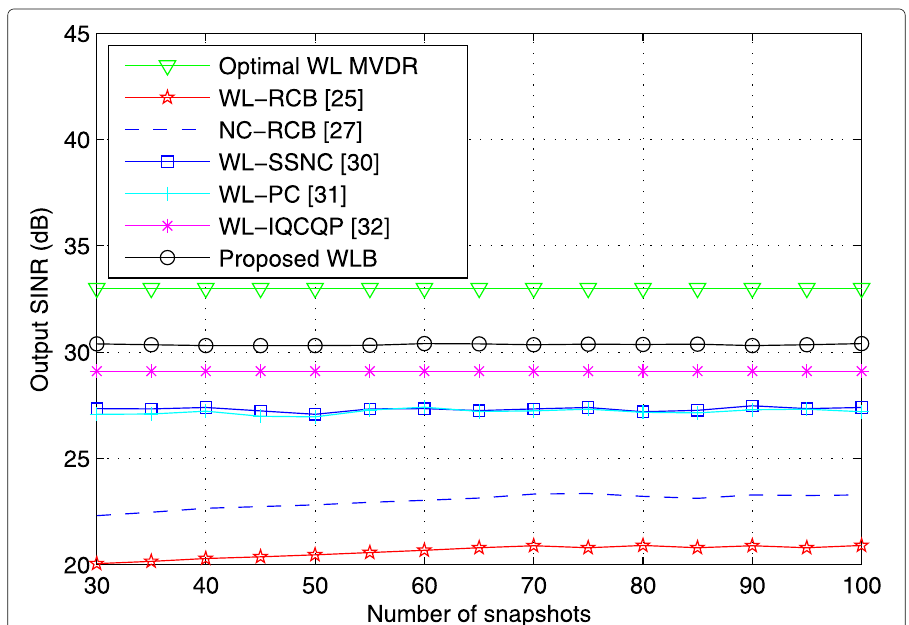
Fig. 7 Example 3. Output SINR of all WLBs versus the number of snapshots K